Question: In a single sentence, describe what this figure presents.
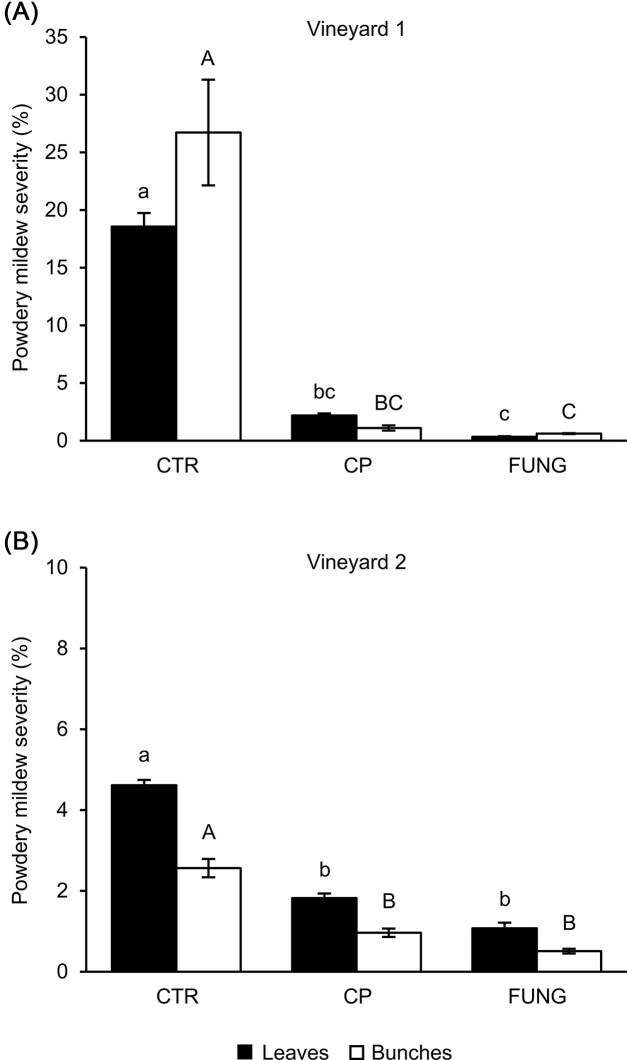
Answer: Choline pelargonate decreased powdery mildew severity under field conditions. Powdery mildew severity was assessed on leaves (black) and bunches (white) of control plants (CTR) and plants treated with 16 mM choline pelargonate (CP) or with a combination of copper and sulfur as reference fungicides (FUNG) in vineyard 1 (A) and vineyard 2 (B). Four plots of twelve plants were analyzed for each treatment in a randomized block design, and powdery mildew severity was assessed as percentage (%) of adaxial leaf area or bunch area covered by powdery mildew symptoms on 60 leaves or 40 bunches per plot at BBCH-77 (8 th July in vineyard 1 and 19 th July in vineyard 2). Mean and standard error values of four biological replicates (plots) are reported for each treatment. Lowercase and uppercase letters indicate significant differences among treatments for leaves and bunches, respectively, according to the Kruskal-Wallis test followed by the Dunn’s test ( P ≤ 0.05), respectively.